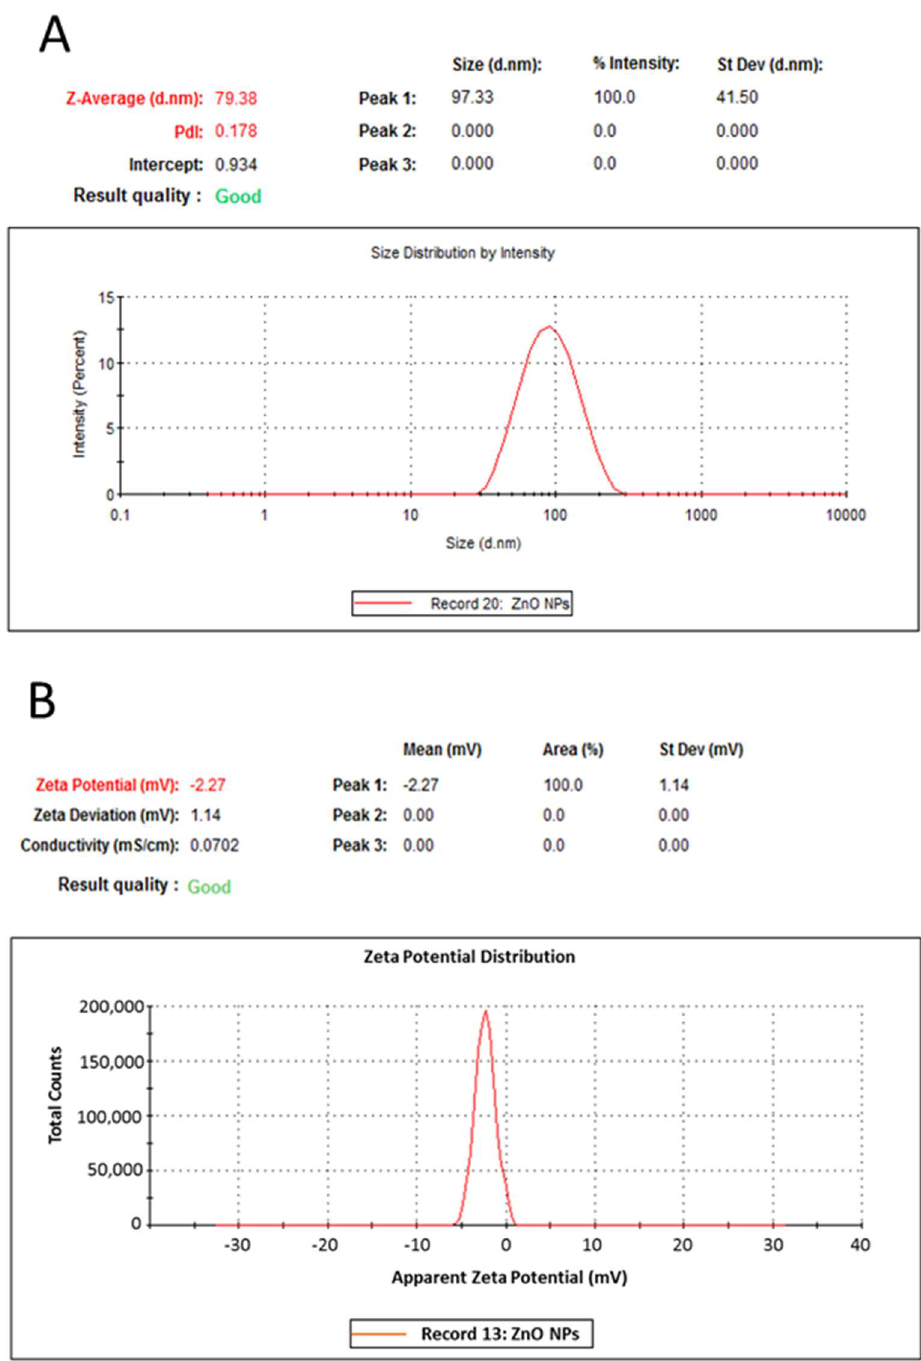
Figure 1. Physicochemical characterization of ZnO nanoparticles. ( A ): particle size distribution measured by DLS. ( B ): Zeta potential measured by ELS.